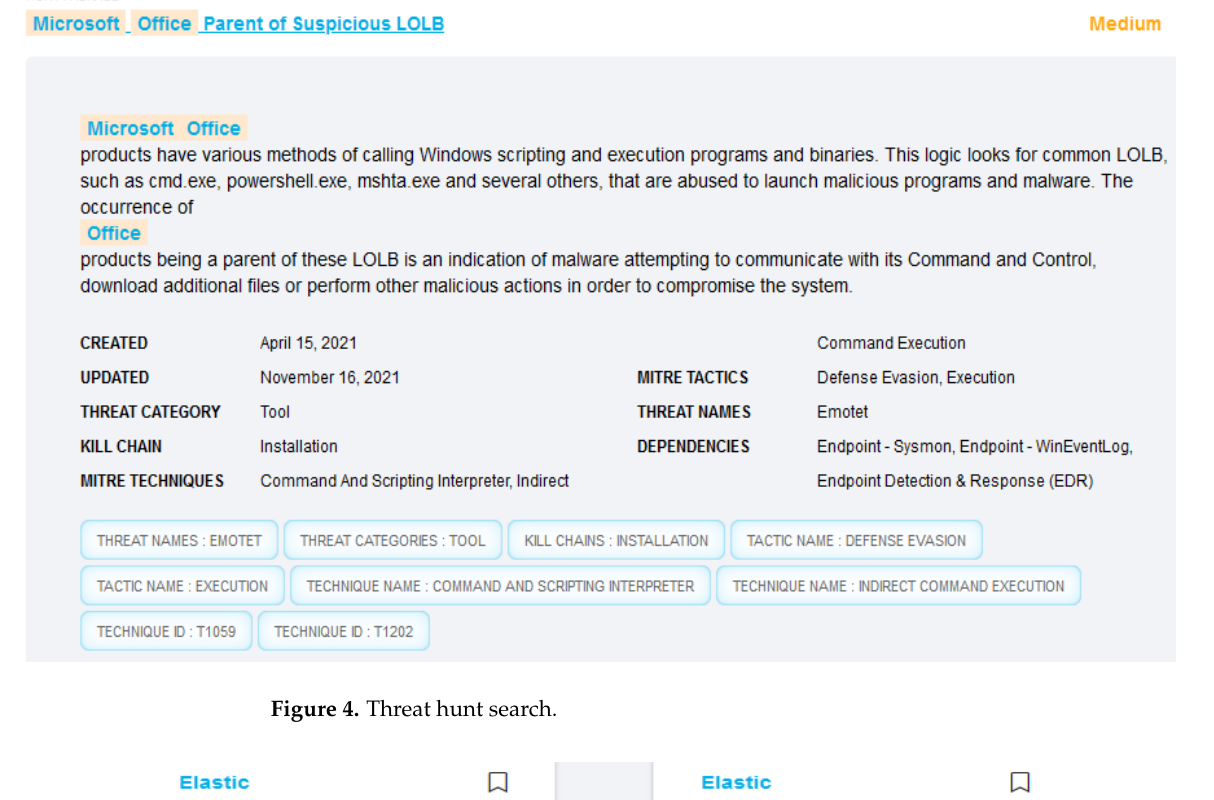
Figure 3. Elastic instance displaying threat logs.